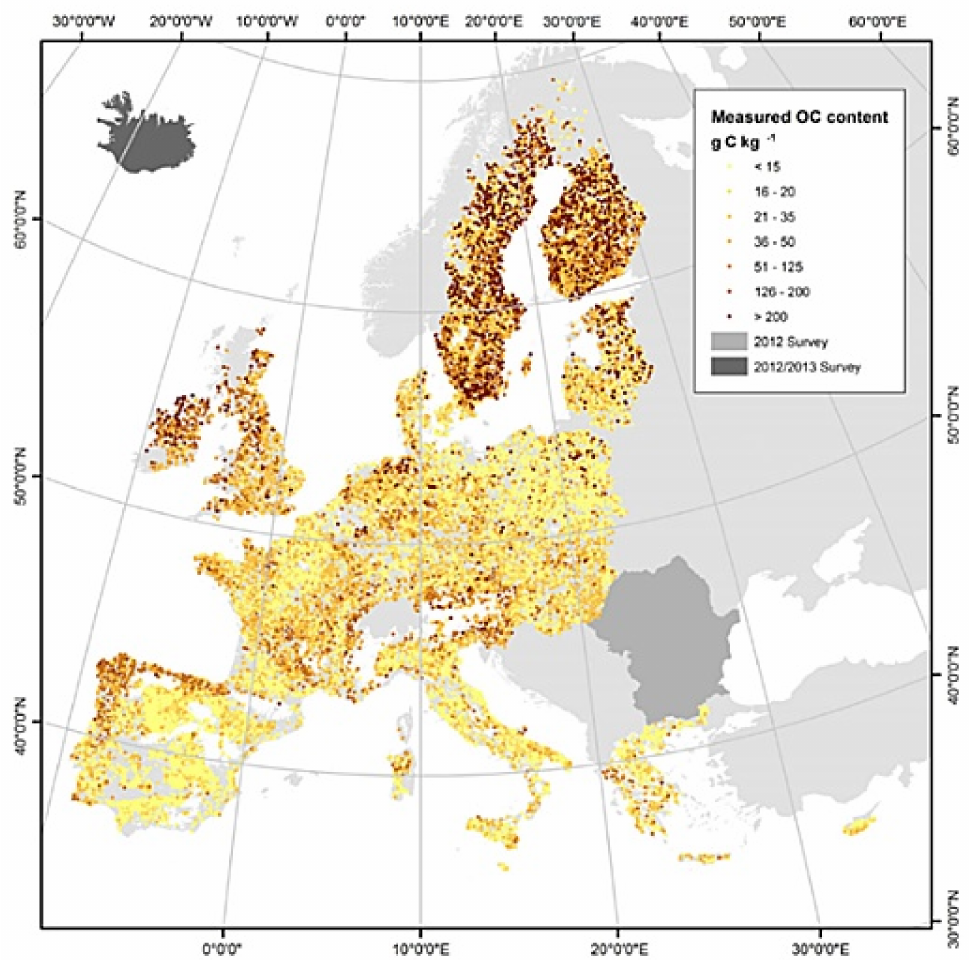
Figure 5. Measured organic carbon content at Land Use / Cover Area frame statistical Survey (LUCAS) topsoil survey (2009) sampling locations. Results of the laboratory analysis for Romania, Bulgaria, and Iceland are awaited